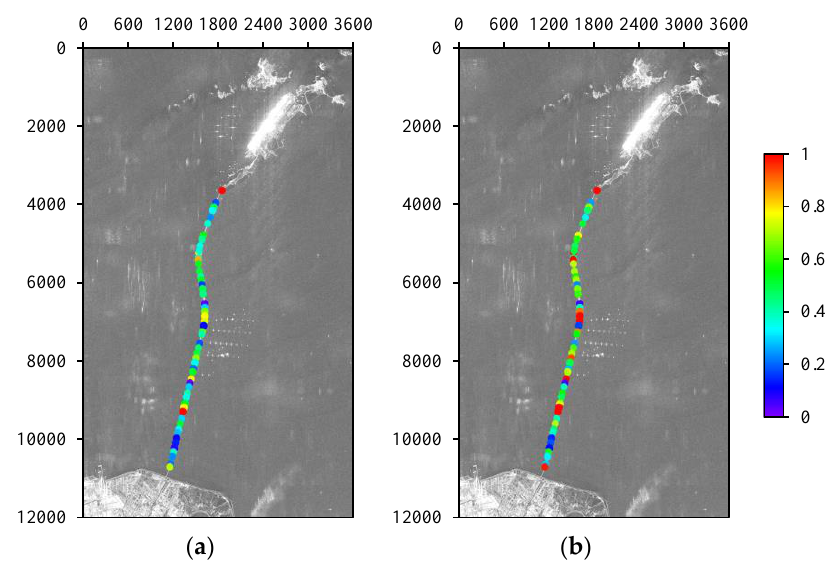
Figure 14. Coherence difference of the bridge between ( a ) the standard method and ( b ) the proposed method.